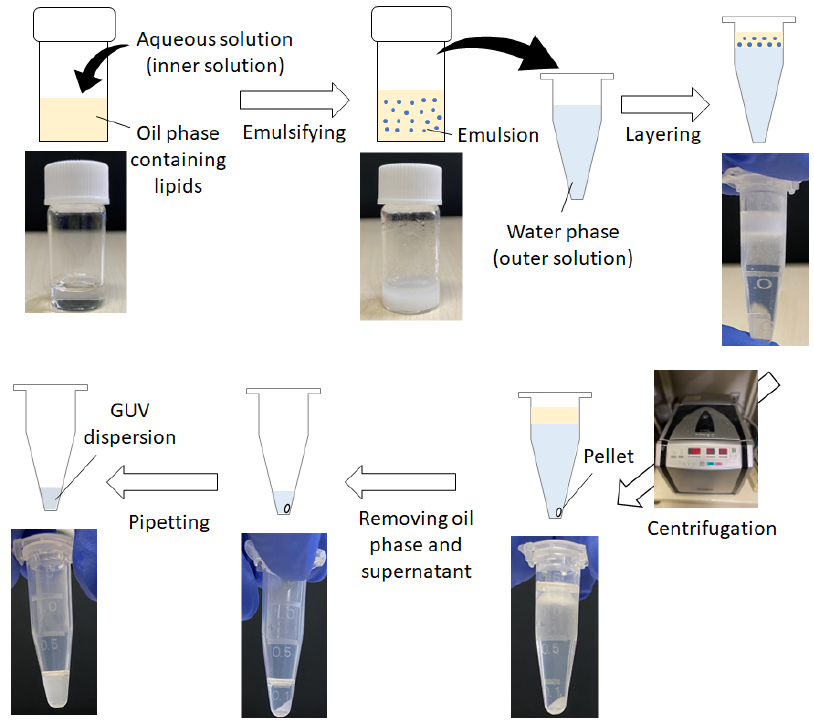
Figure 3. Schematic illustration of the protocol of the W/O emulsion template method with centrif- ugation.